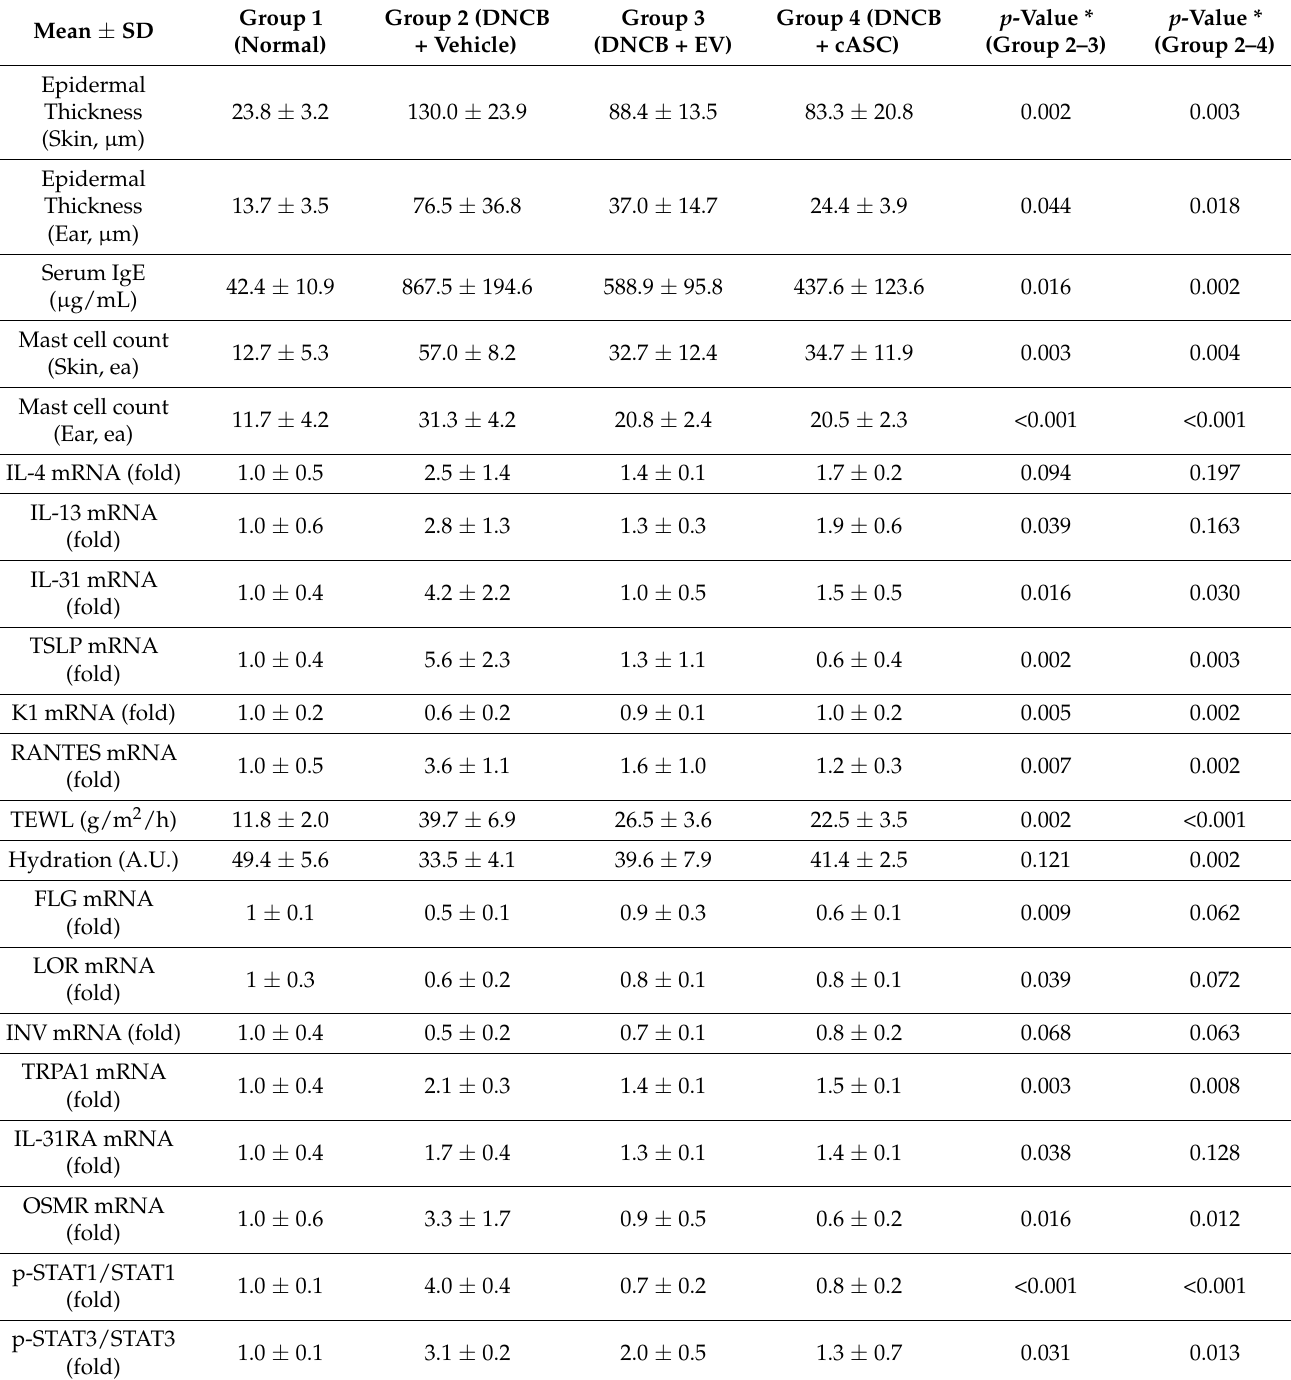
Table 1. Statistical analysis I (parametric